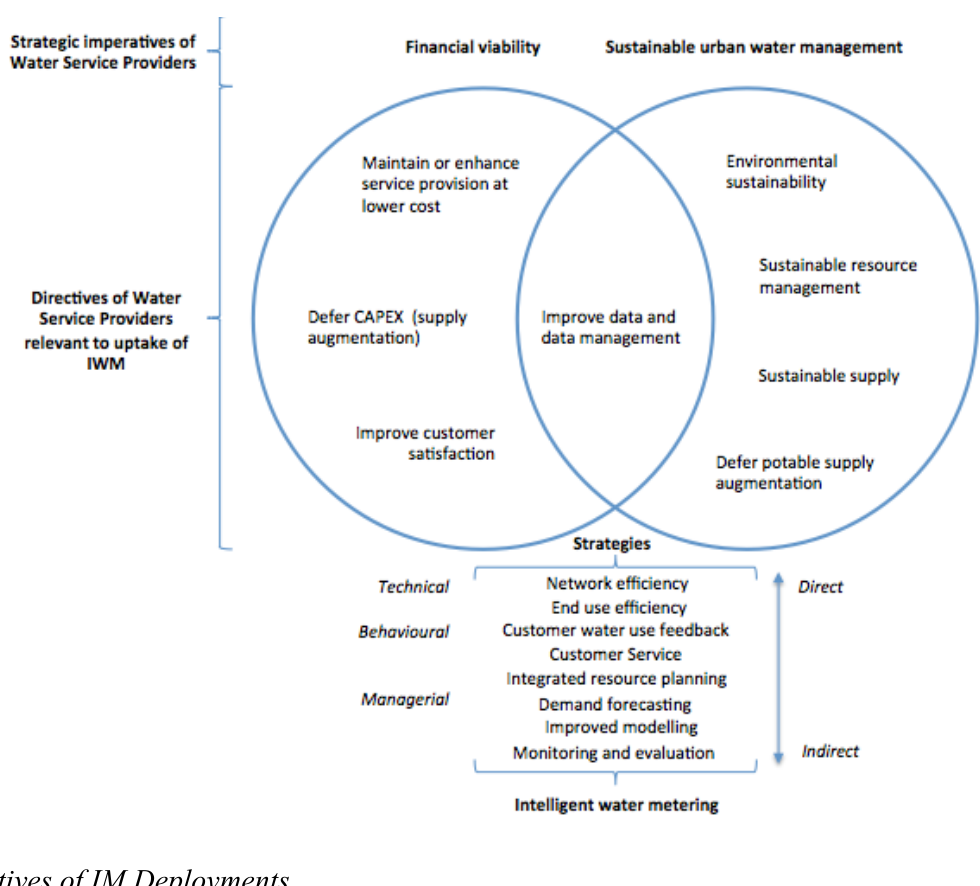
Figure 3. Locating rationale for IM.